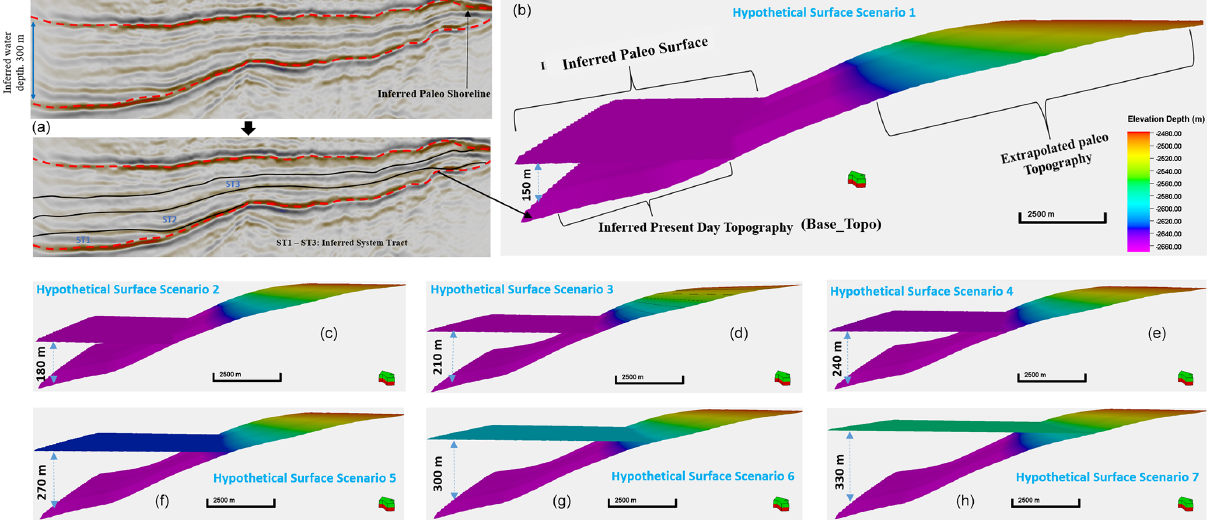
Figure 4. Illustration of a range of hypothetical initial topographic surfaces that were used to mitigate the uncertainty in selecting an ini- tial topographic surface for the simulation. Considering that the topographic surface is a key control on stratigraphic sequence, different stratigraphic models are generated to attain a “best-fit”